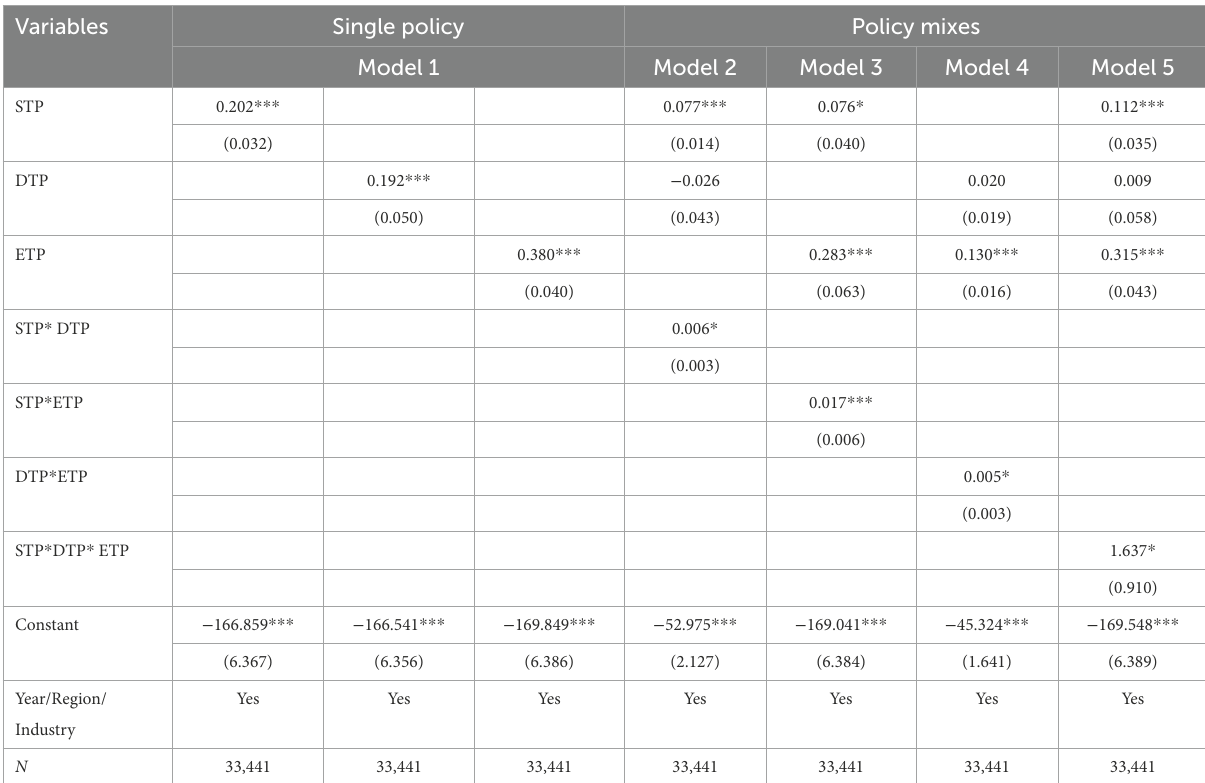
TABLE 10 Estimation for altering the regression